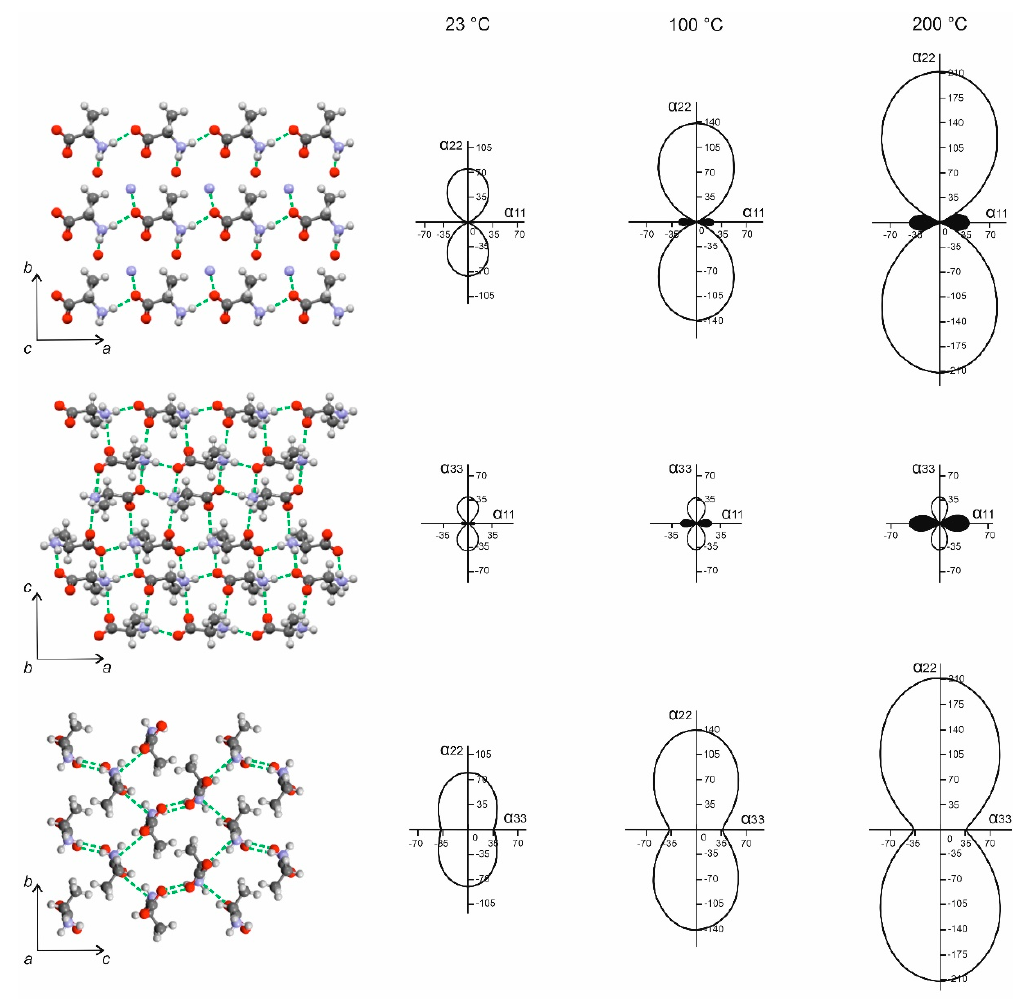
Figure 9. Projections of the figures of the thermal expansion coefficients (CTE) onto the ab , ac, and bc planes of the L-ala orthorhombic cell. The CTE figures are plotted for the temperatures of 23, 100, and 200 °C. Hydrogen bonds are shown as dashed lines. The projections of the orthorhombic cell are plotted using the structural data from CSD (identifier LALANINE54) [35].